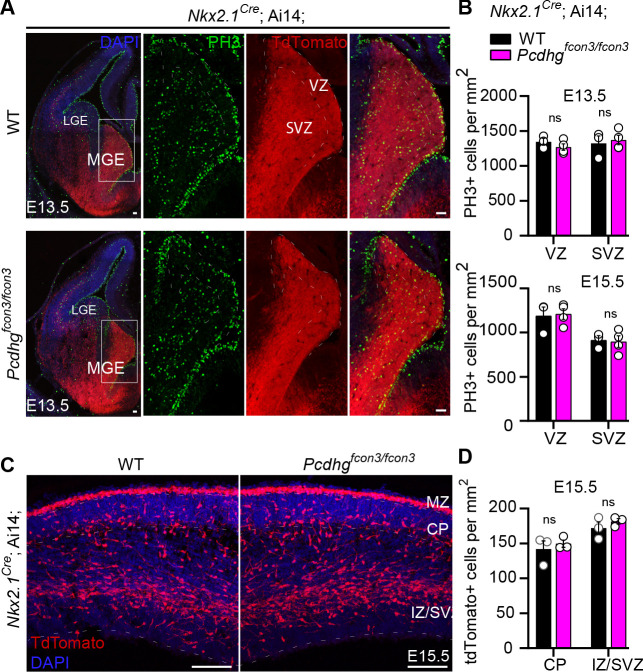
Proliferation and migration are not affected by the loss of Pcdhg in NKX2.1 expressing cells.( A) Photographs of coronal sections through the embryonic forebrains of E13.5 Nkx2.1Cre;Ai14;Pcdhg+/+ (Pcdhg WT, top panels) and Nkx2.1Cre;Ai14;Pcdhgfcon3/fcon3 (Pcdhg mutant, bottom panels). Close-up photographs of the MGE from Nkx2.1Cre;Ai14;Pcdhg WT (right panels) and Pcdhg mutant (bottom, right panels) embryos. Robust reporter activity (tdTomato) was observed in the MGE. Dividing cells were labeled using the mitotic marker PH3. Note that the size and number of PH3+ cells in the MGE was similar in the mutant and control brains. Scale bars, 50 μm. (B) Quantification of PH3+ cells from MGE ventricular (VZ) and subventricular zone (SVZ) in E13.5 (top) and E15.5 (bottom) Nkx2.1Cre;Ai14;Pcdhg WT (black bars) and Pcdhg mutant (magenta bars) embryos (Mann-Whitney test, p=0.4000 (E13.5 VZ), p=0.8571 (E13.5 SVZ), p=0.8571 (E15.5 VZ), p>0.999 (E15.5 SVZ), n = 3–4 embryos of each genotype). (C) Photographs of coronal sections of dorsal cortex at E15.5 showing the migrating MGE-derived cIN in Nkx2.1Cre;Ai14;Pcdhg WT (left) and Pcdhg mutant (right) embryos. Note the robust migratory streams of young neurons in the SVZ and in the marginal zone (MZ). From these regions, cells disperse into the intermediate zone (IZ) and cortical plate (CP). Similar numbers of migrating cIN were observed in mutants and controls. Scale bar, 100 μm. (D) Quantifications of number of migrating MGE-derived cINs in the CP and in the IZ/SVZ of Nkx2.1Cre;Ai14;Pcdhg WT (black) and Pcdhg mutant (magenta) mice. No significant differences were detected in the number of tdTomato+ migrating cells in Pcdhg mutant and WT controls (Mann-Whitney test, p>0.990 (E15.5 CP), p=0.7000 (E15.5 IZ-SVA), n = 3 embryos of each genotype).
Figure 4—source data 1.Quantification of PH3 positive cells in the embryonic MGE and number of Nkx2.1-derived cINs in the embryonic dorsal cortex of controls and Pcdhg loss of function mice.